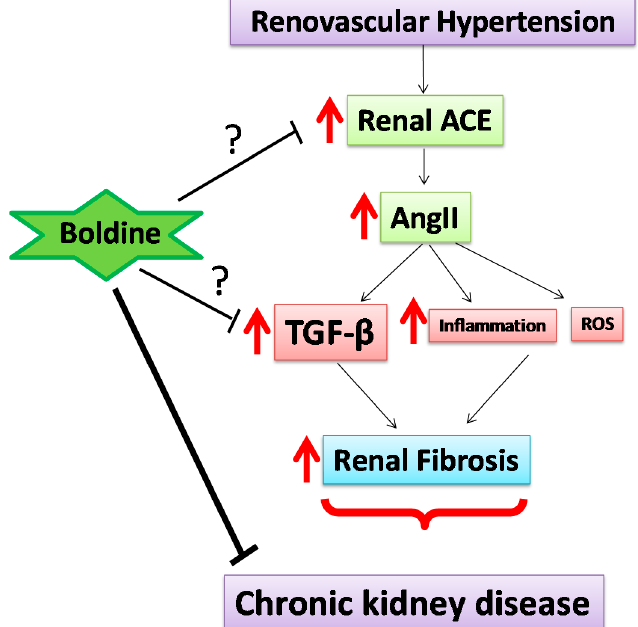
Figure 8. Mechanism in which the 2K1C hypertensive rat model leads to the development of renal damage and boldine would cause the reduction of kidney damage. RAS is a key mediator in chronic kidney damage as it participates in the development of fibrosis by stimulating the synthesis of TGF- β . In addition, high levels of Ang II maintained for long periods can induce the inflammatory response and generation of ROS, contributing to the onset of oxidative stress (red arrows). Therefore, Ang II is a key mediator in chronic kidney disease as it participates in the development of fibrosis by stimulating the synthesis of TGF- β (red arrow). Boldine could prevent the increase in ACE-1, causing a decrease in all downstream mediators, including TGF- β and mediators downstream of this marker; and could even prevent the same increase of TGF- β (question mark), suggesting that boldine reduces kidney damage affecting the RAS in the kidney of 2K1C